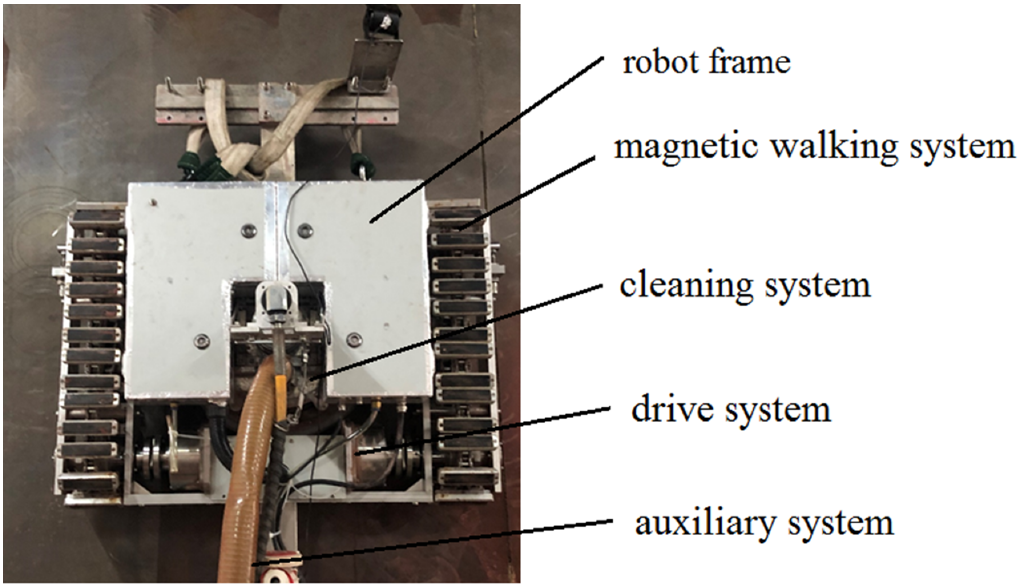
Figure 1. Structure of the wall-climbing robot.